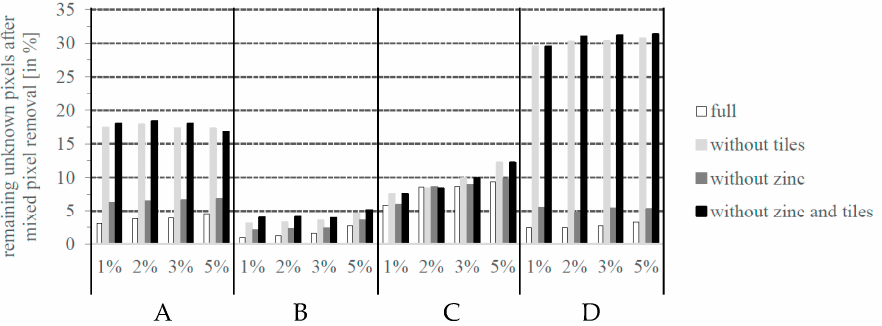
Figure 5. Remaining unknown artificial pixels after single and border pixel removal.